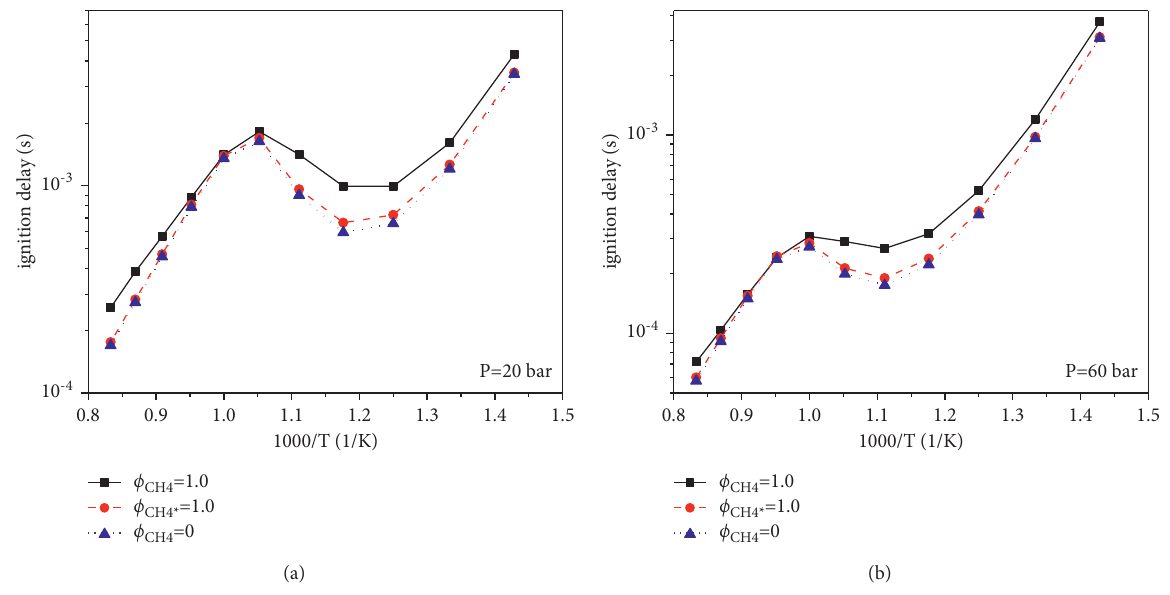
� 0.5, 1, and 1.5. total